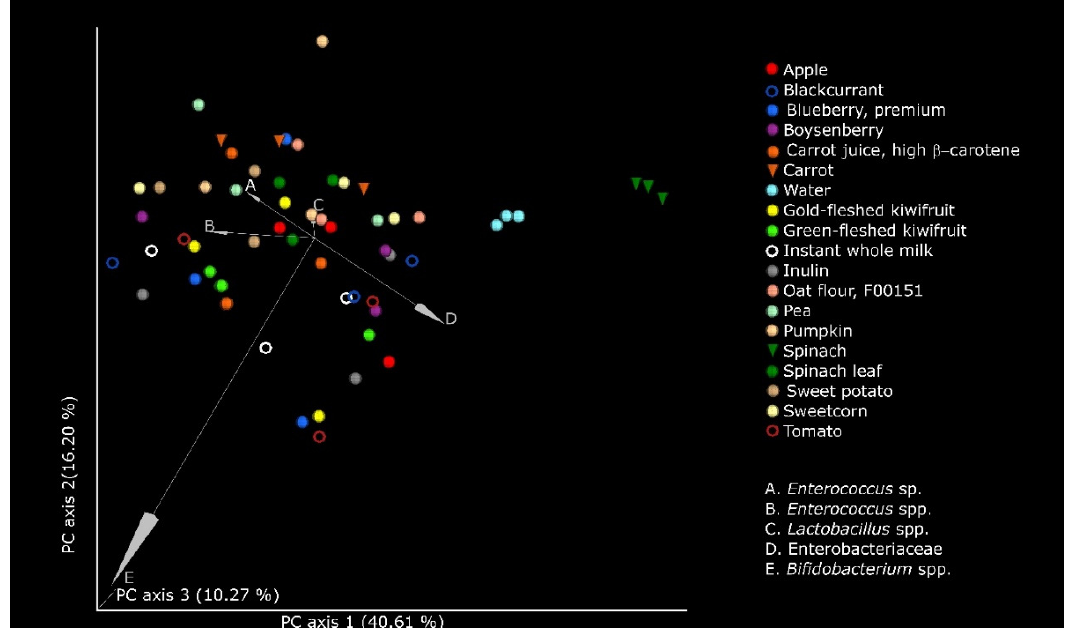
Figure 4. Principal coordinates analysis (PCoA) plots based on weighted UniFrac distances demonstrating significant shifts in the microbiome structure at 10 h of fermentation of the food ingredients, inulin (positive control), and water. Each sample was anaerobically fermented in triplicate, in the presence of pooled infant fecal slurry. The axes represent the dimensions explaining the greatest proportion of variances in the communities. The statistical significance ( p < 0.005) was computed using permutational multivariate analysis of variance (PERMANOVA).